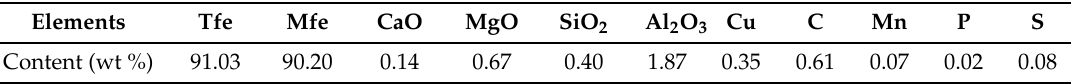
Table 2. Chemical composition of obtained iron powder from grinding/magnetic separation.